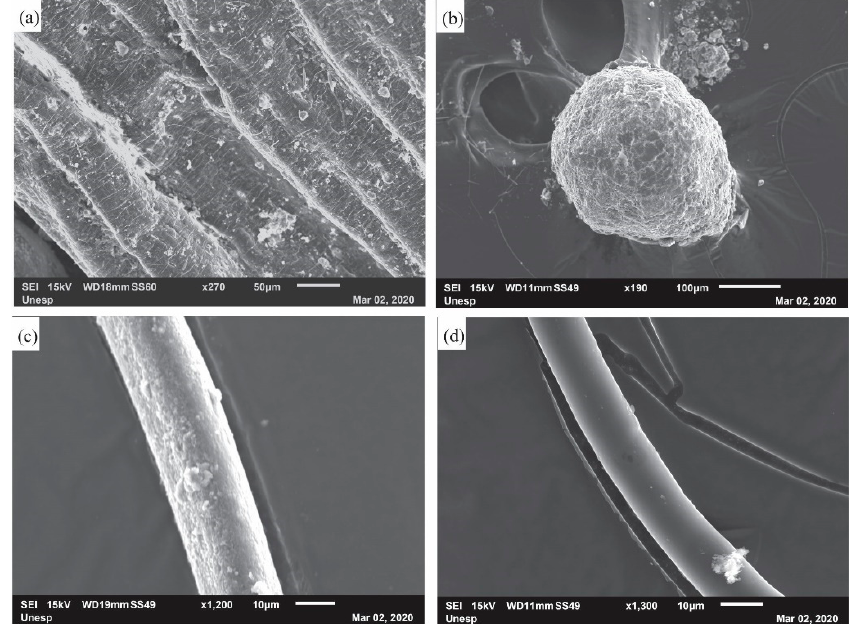
Figure 6. SEM-EDS micrographs of MPs. ( a ) plastic bag film); ( b ) black pellet; ( c ) red fiber; and ( d ) blue line.